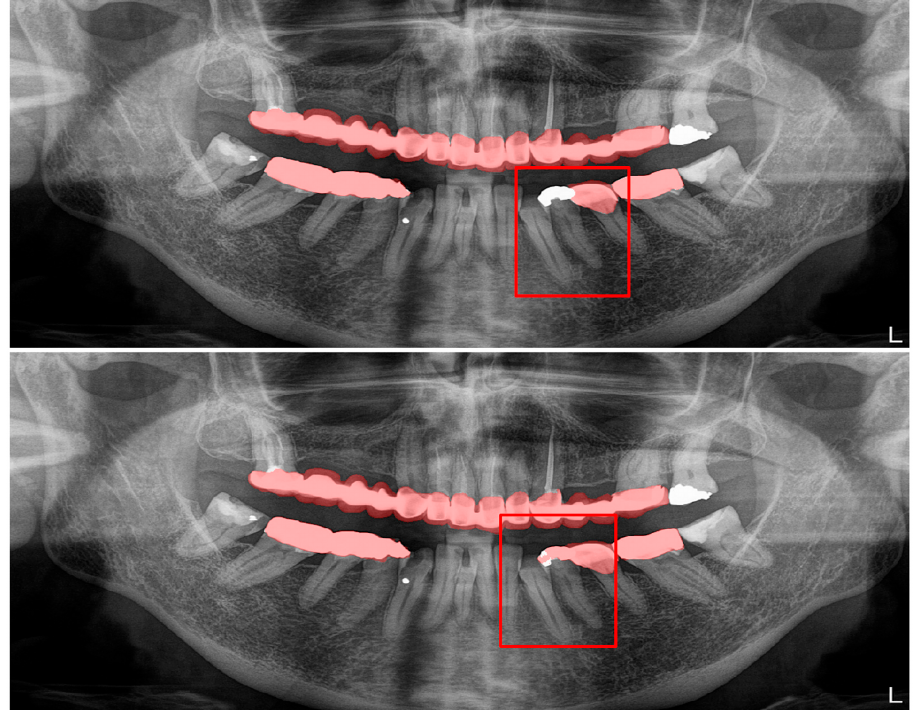
Figure 10. A wide amalgam restoration in the mandibular left first premolar tooth was mis-segmented as a crown restoration. Manual segmentation (upper image) and automatic segmentation (lower image) can be seen above. Although the DSC for dental implant segmentation was 0.94 in our study, after check- ing the output data it was seen that the implant abutments were segmented as dental im- plants or crowns (Figure 11).